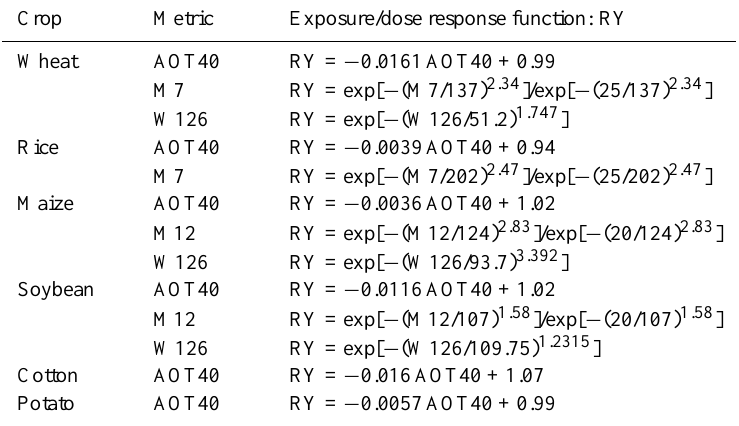
Table 2. Ozone exposure/dose response functions for wheat, rice, maize, soybean, cotton and potato based on the AOT40, M7, M12 and W126 indices. The AOT40 relationships are described in Mills et al. (2007). The M7, M12, and W126 relationships are described in Wang and Mauzerall (2004). Crop Metric Exposure/dose response function: